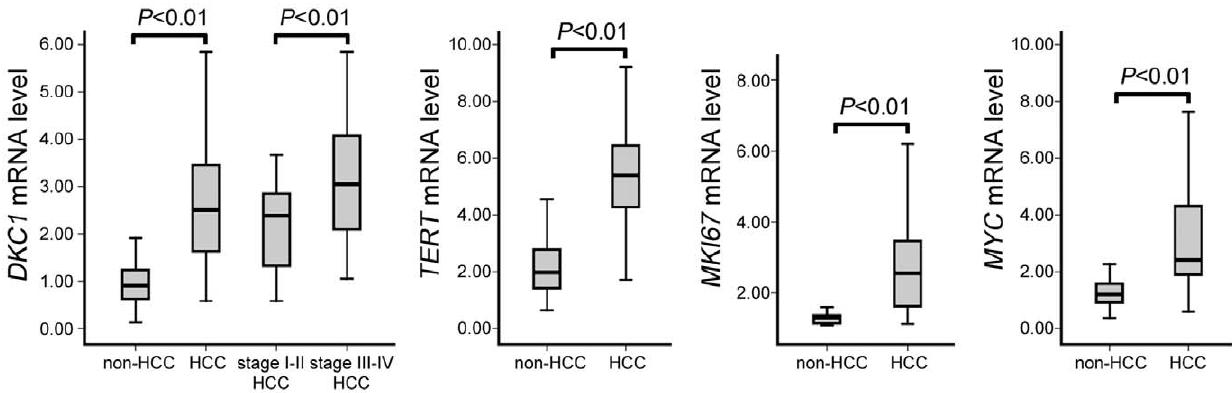
Figure 3. A quantitative real-time PCR analysis of DKC1 , TERT , MKI67 , and MYC mRNA levels in HCC tissues and noncancerous liver tissues. mRNA expression was evaluated relative to the expression of the reference gene GAPDH . The data for each sample were averaged from three independent experiments.